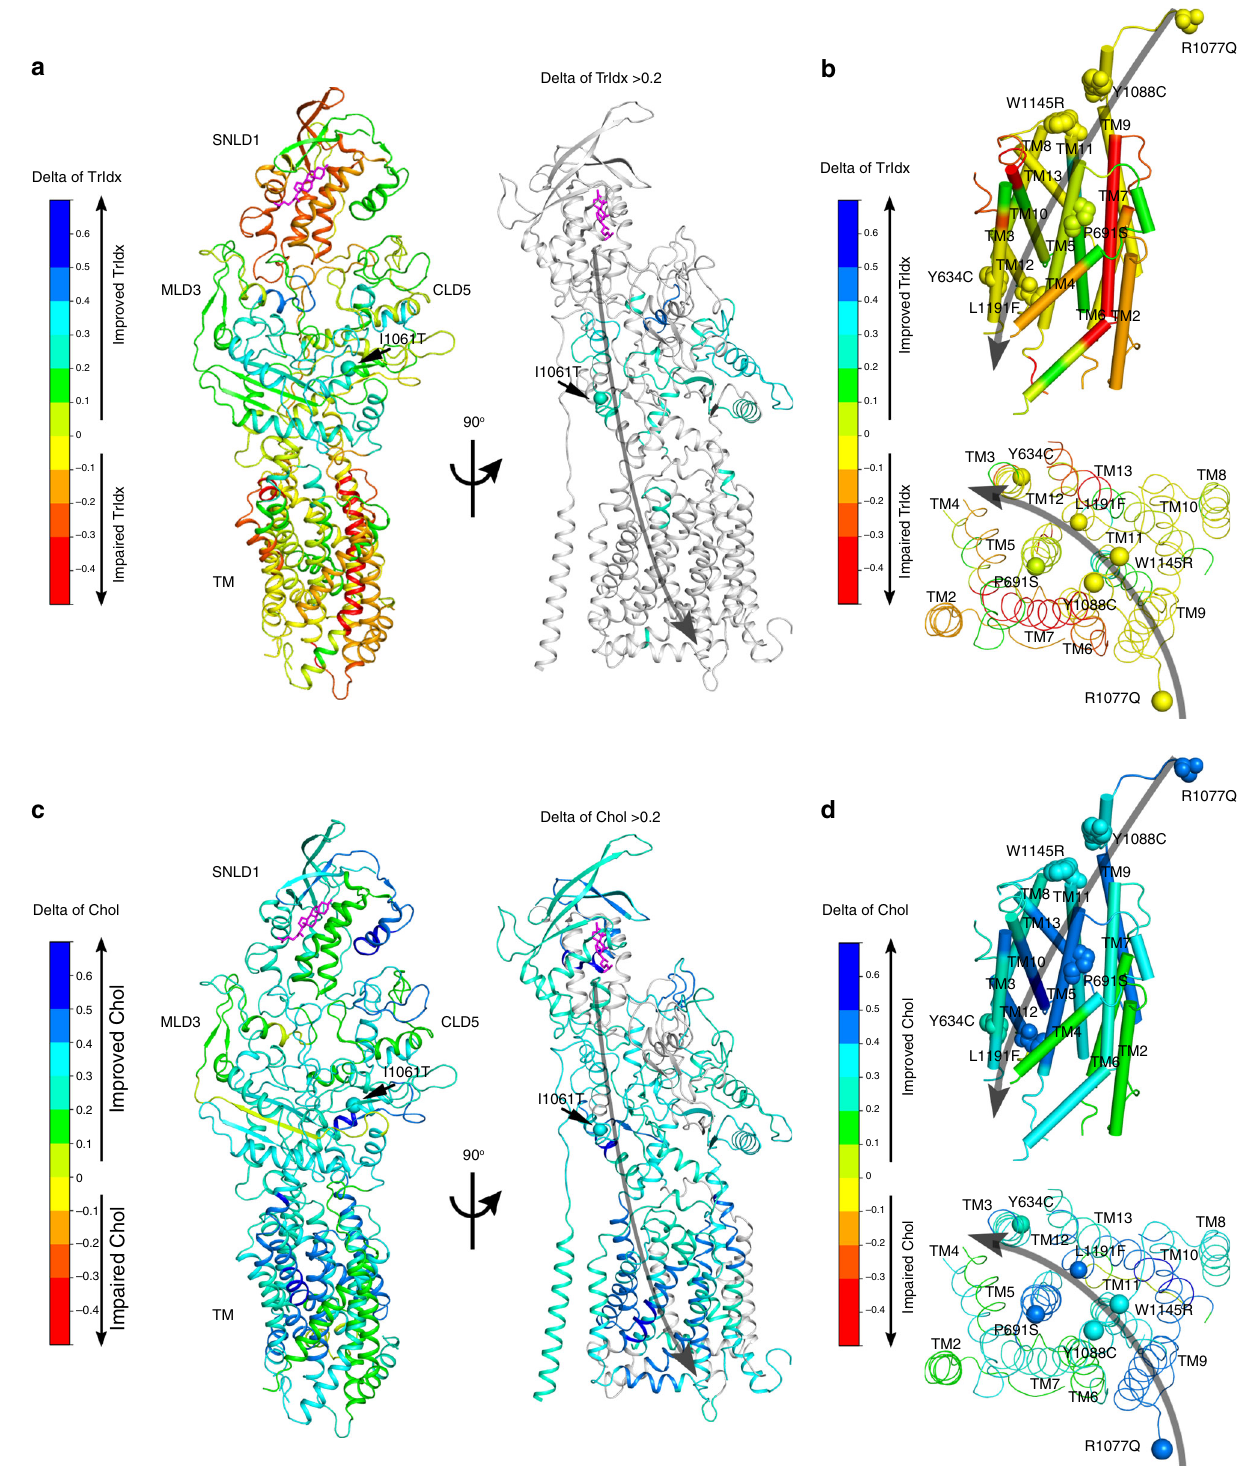
Fig. 4 The SAHA responsive structures for TrIdx and Chol. NPC1 structure is colored by the predicted delta value of TrIdx ( a , b ) or delta value of Chol ( c , d ) in response to SAHA. Color-scale values: impair of TrIdx or Chol homeostasis (red-orange), no change (yellow), improve of TrIdx or Chol homeostasis (cyan-blue). In the right panel of ( a ) and ( c ), regions with delta value< 0.2 are shown in gray to highlight the regions corrected by HDACi (i.e., delta value> 0.2). Transmembrane helices 1 – 13 are labeled in panels ( b ) and ( d ). Variants critical for predicted cholesterol fl ow path are highlighted and labeled in